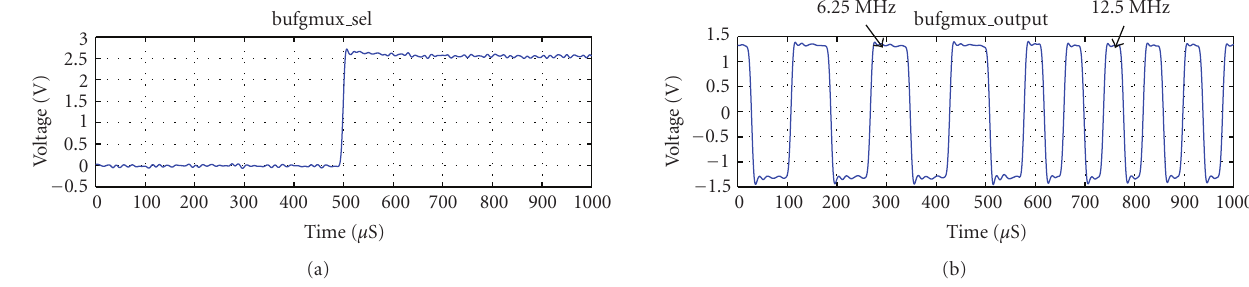
Figure 6: BUFGMUX clock switching: bufgmux sel signal and bufgmux output